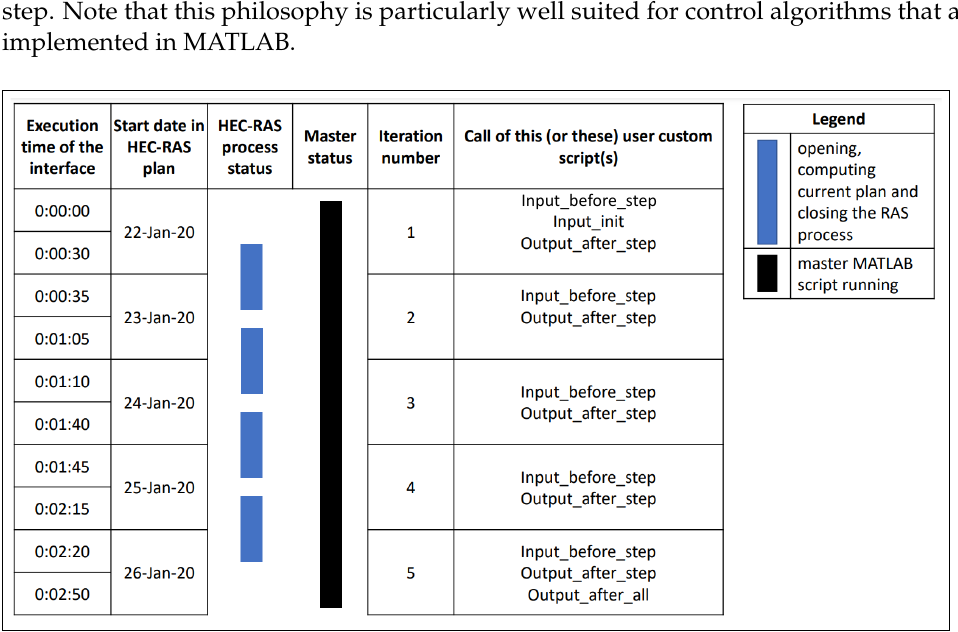
Figure 2. Illustration of the MATLAB HEC-RAS interface operation allowing step-by-step simula-